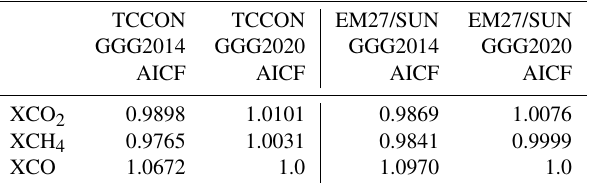
Table 5. Air-mass-independent correction factors (AICFs) used for TCCON and EM27/SUN devices for GGG2014 and